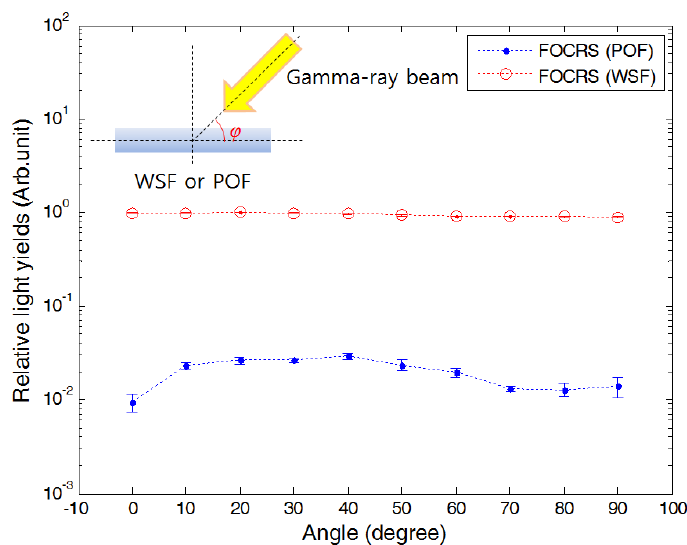
Figure 10. Angular dependence of